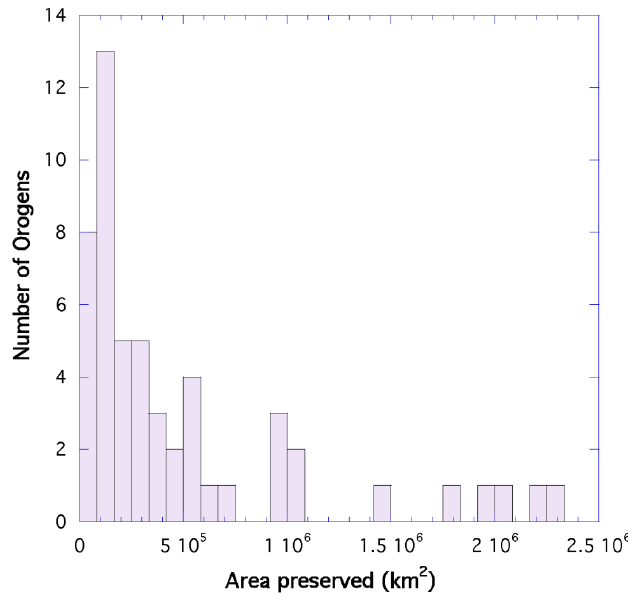
Figure 8. Frequency of area preserved of Proterozoic orogens (data from Appendix